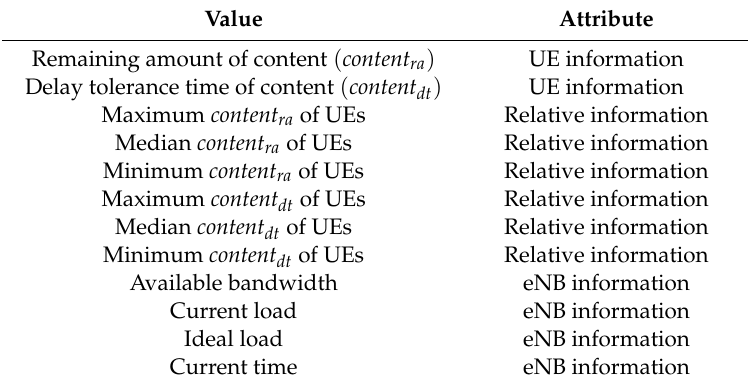
Table 1. Learning parameters of the proposed method at t